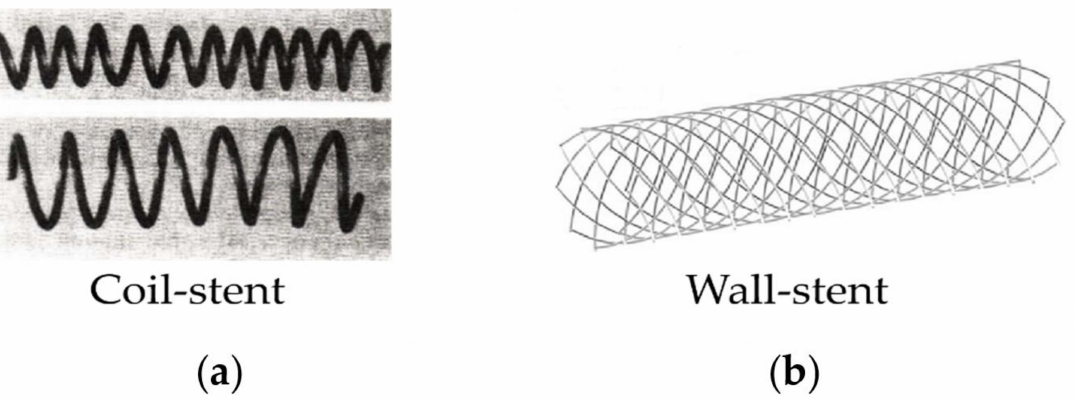
Figure 3. Two structures of braided stents: ( a ) Coil-stent [28]; ( b ) Wall-stent